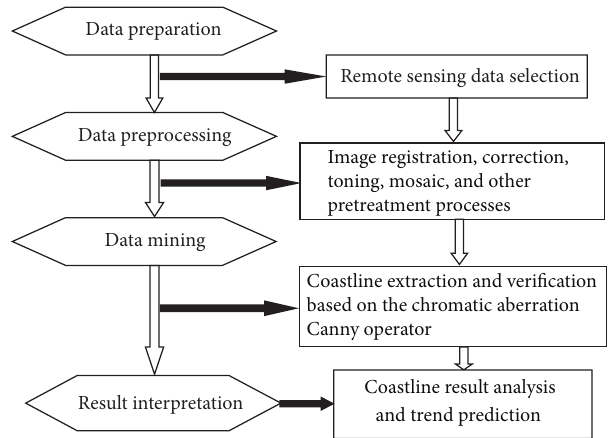
Figure 1: Coastline extraction flow chart based on data mining.